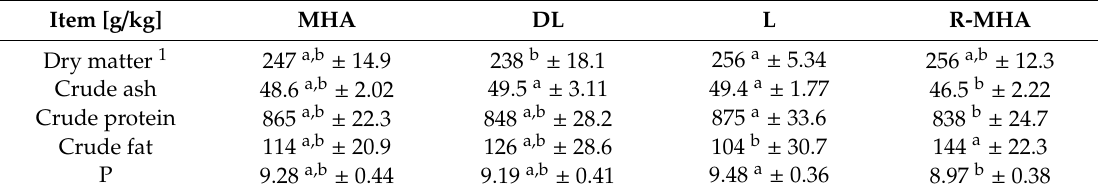
Table 9. Analysis of the breast meat of 24 broilers (day